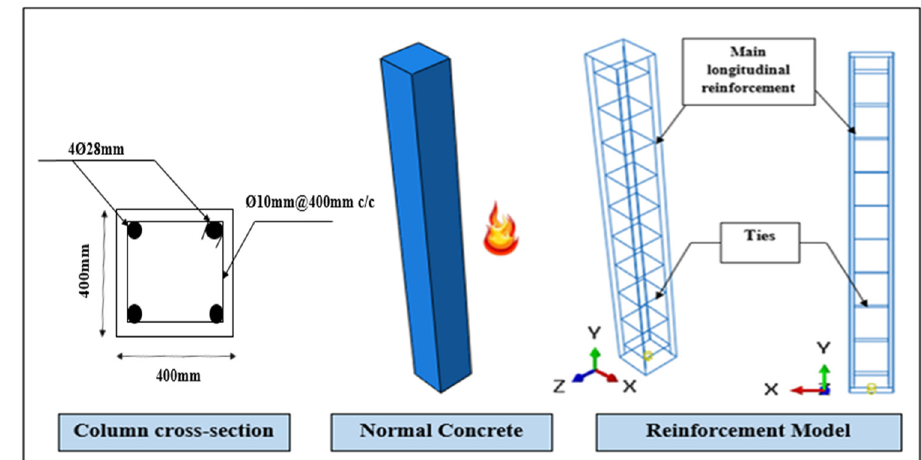
Figure 1: Details of dimensions and reinforcement of concrete column